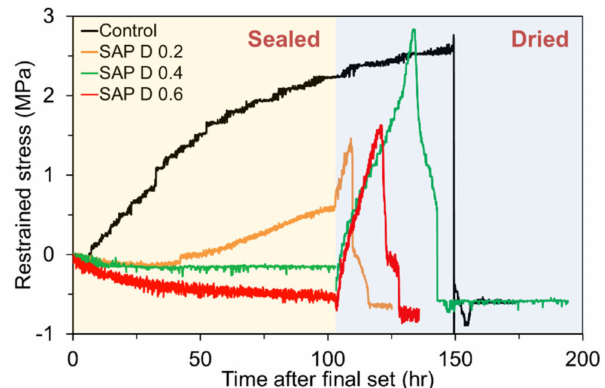
Figure 18. Restrained stress development in mortar ring specimens with different SAP contents when drying initiated after 100 h of final